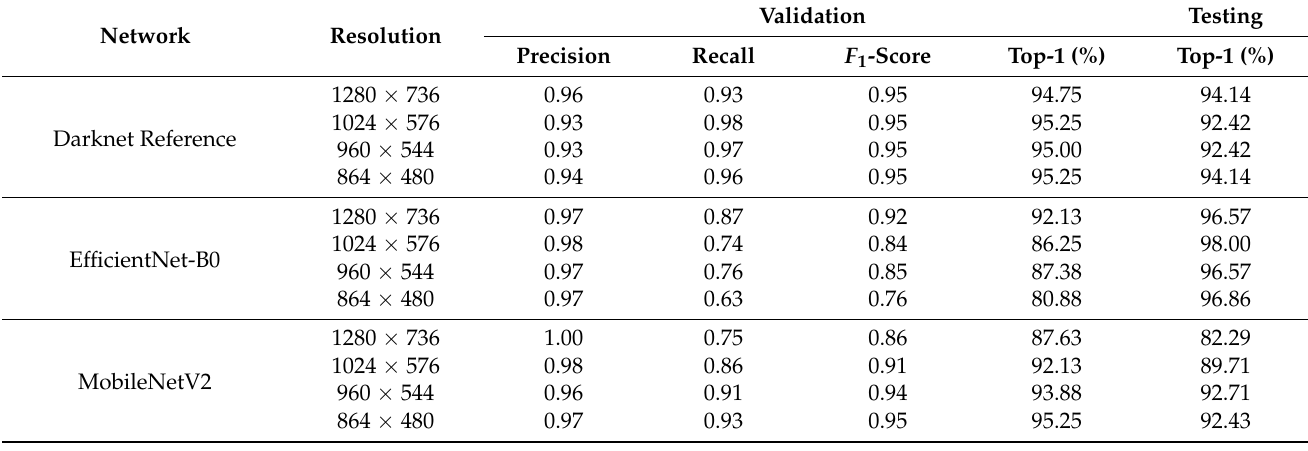
Table 6. Classification results for images with or without sheep sorrel.